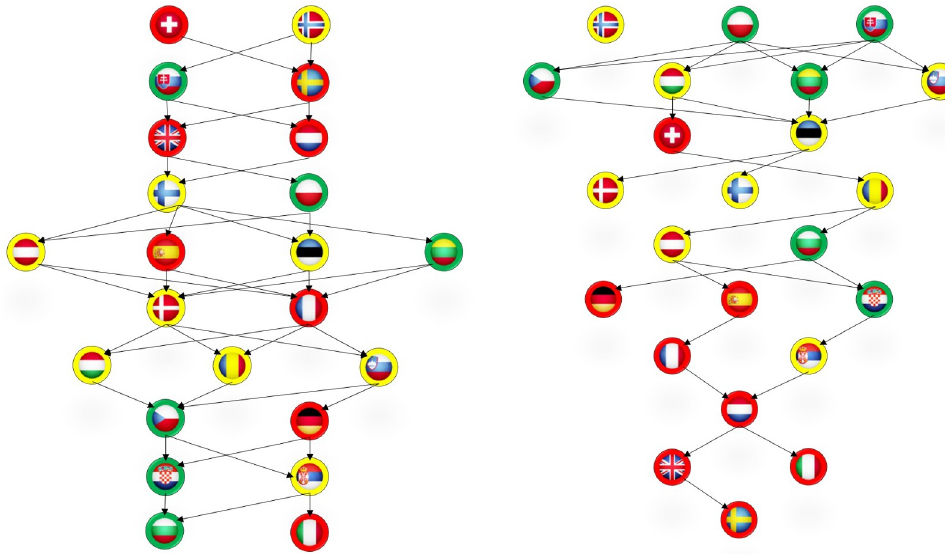
Fig 1. Hierarchical order of countries based on readiness dimensions (left) and structure +reaction dimensions (right).